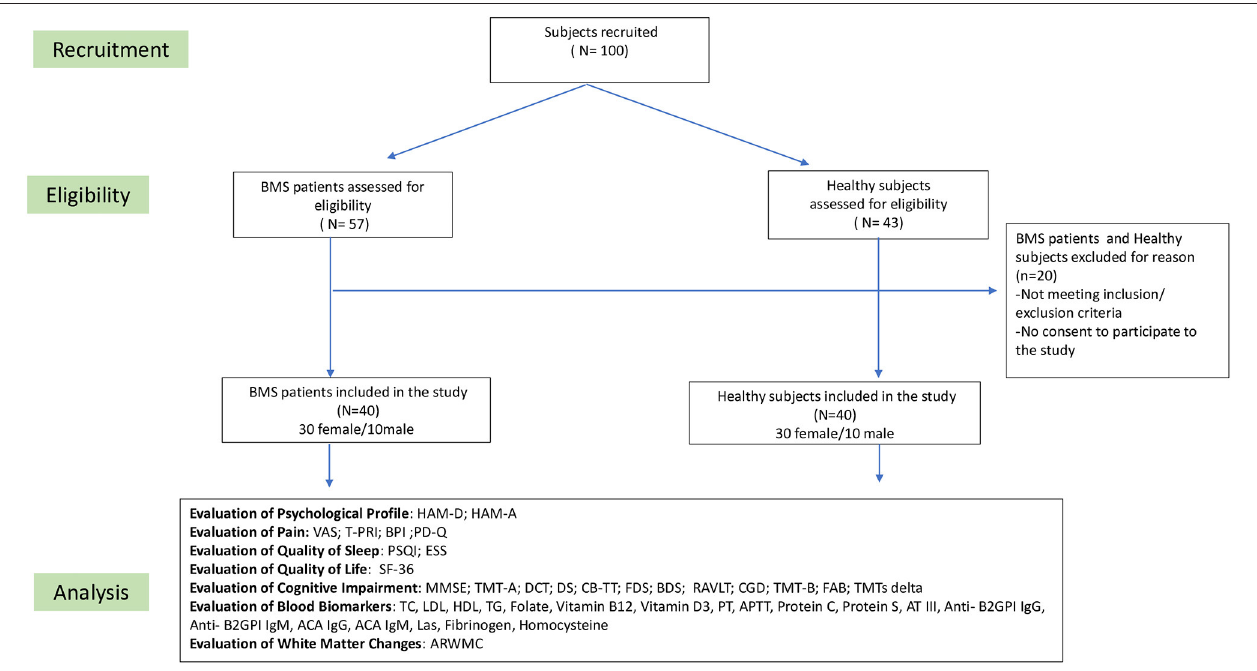
FIGURE 1 | The flowchart of this